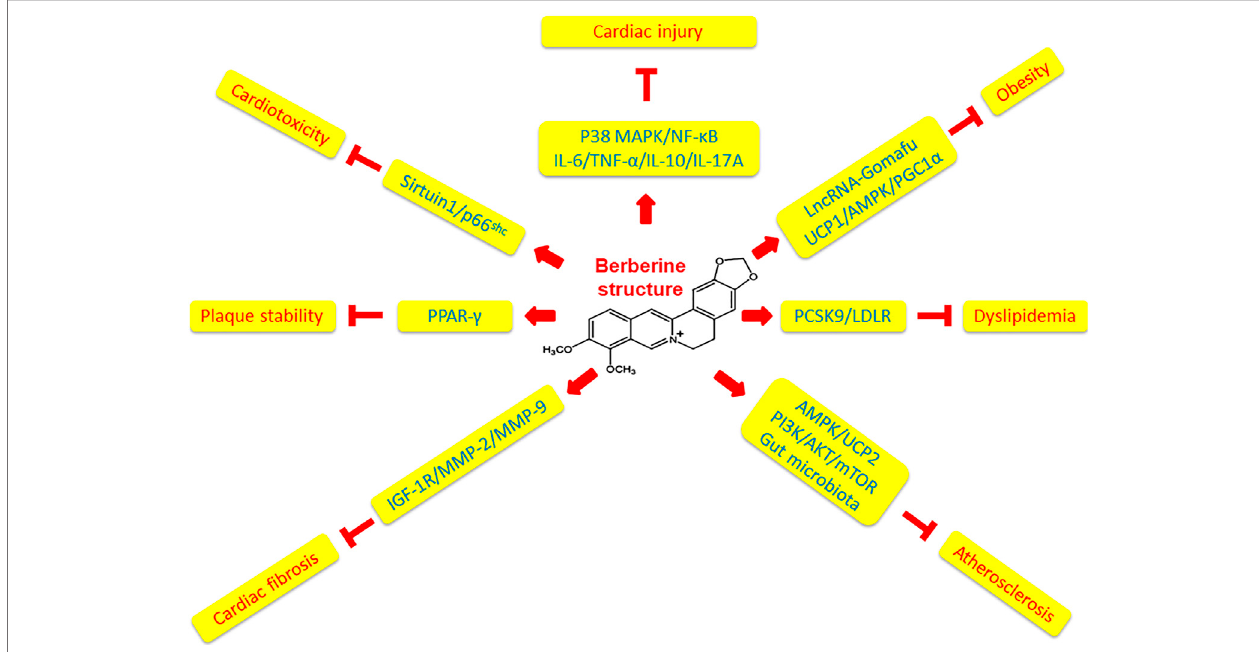
FIGURE 2 | Mechanisms of berberine affecting atherosclerotic cardiovascular diseases. Berberine has pleiotropic effects on cardiovascular diseases via multiple mechanisms. Berberine protects cardiac injury by downregulating the expression of in fl ammatory cytokines including IL-6, TNF- α , IL-10 and IL-17A via p38 MAPK- mediated NF- κ B signaling pathways. Berberine ameliorates obesity via downregulating lncRNA Gomafu and modulating UCP1/AMPK/PGC1 α signaling pathways. Berberine inhibits dyslipidemia through regulating PCSK9/LDLR pathways. Berberine suppresses atherosclerosis via activating AMPK/UCP2 signaling pathways, regulating PI3K/AKT/mTOR molecular pathways, and modulating gut microbiota. Berberine reduces cardiac fi brosis via inhibiting IGF-1R/MMP-2/MMP-9 signaling pathways. Berberine activates PPAR c to increase atherosclerotic plaque stability. Berberine ameliorates doxorubicin-induced cardiotoxicity through Sirtuin1/p66 shc